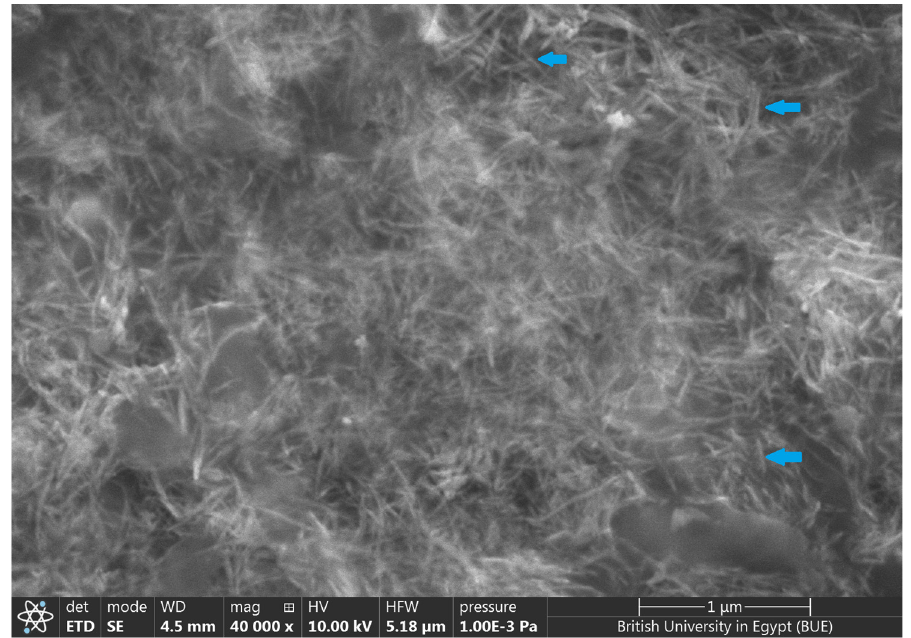
Figure 4. Scanning electron micrograph showing the rod-shaped biogenic TeNPs produced by Gayadomonas sp. TNPM15. The blue arrows indicate the formation of rod-shaped nanostructures.